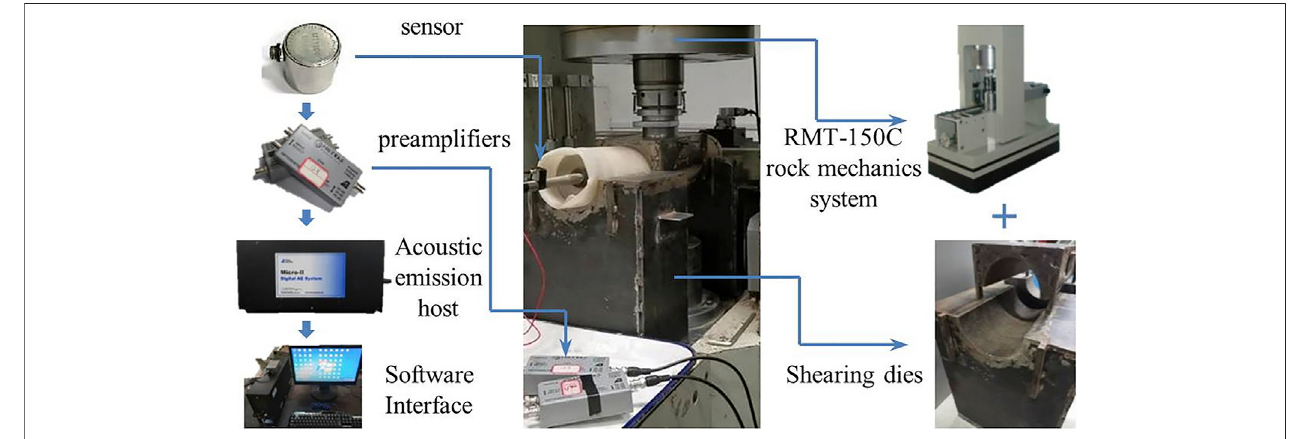
FIGURE 5 | Experimental systems and